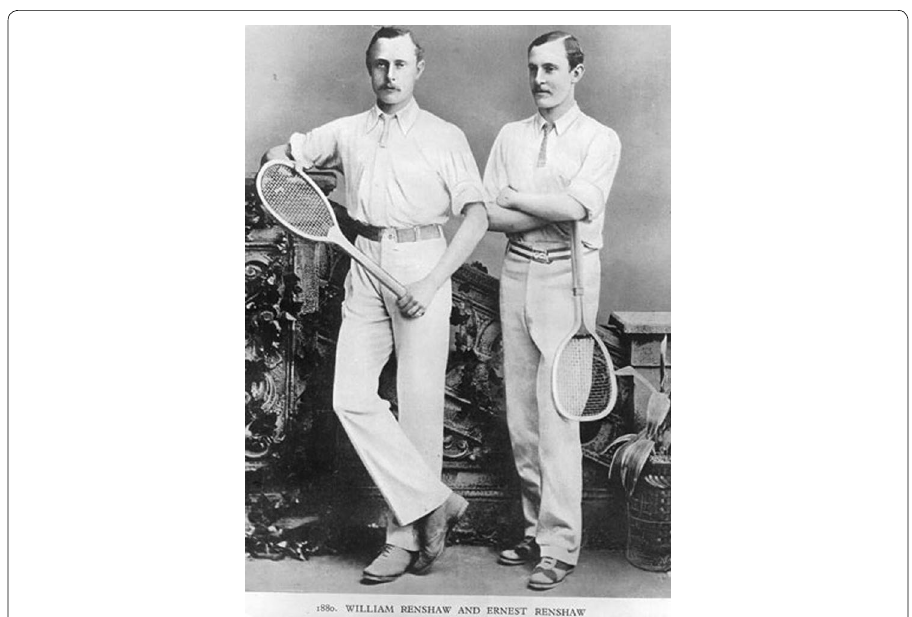
Fig. 2 Male tennis clothing, 1880 (Wimbledon winners William and Ernest Renshaw). Photograph: Don Lope (Wikipedia public domain)